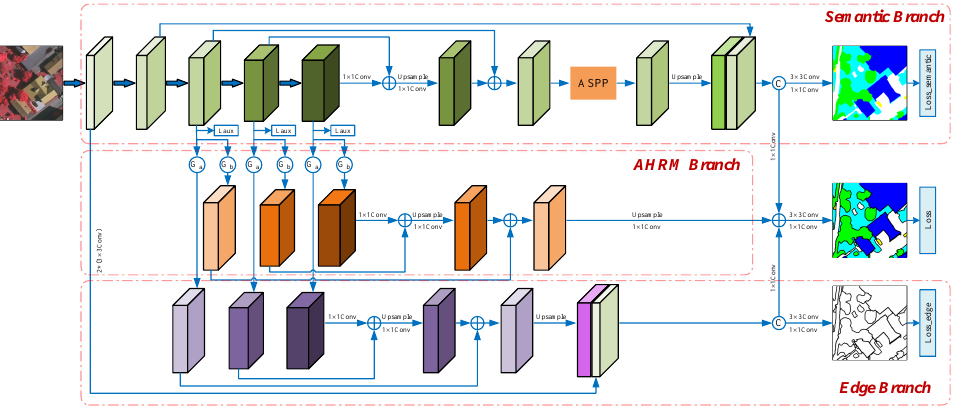
Figure 1. The framework of our